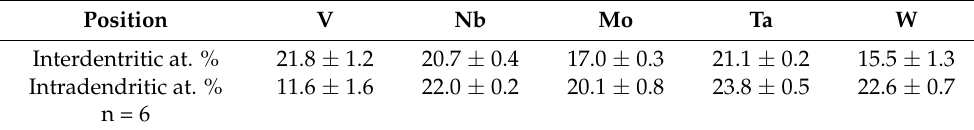
Table 3. Quantitative point measurements in the interdendritic area and the intradendritic area of a PBF-LB/M B sample, respectively; mean value and standard deviation of 6 measurements each. Position V Nb Mo Ta W Interdentritic at. % 21.8 ± 1.2 Intradendritic at. % 11.6 ± 1.6 n =